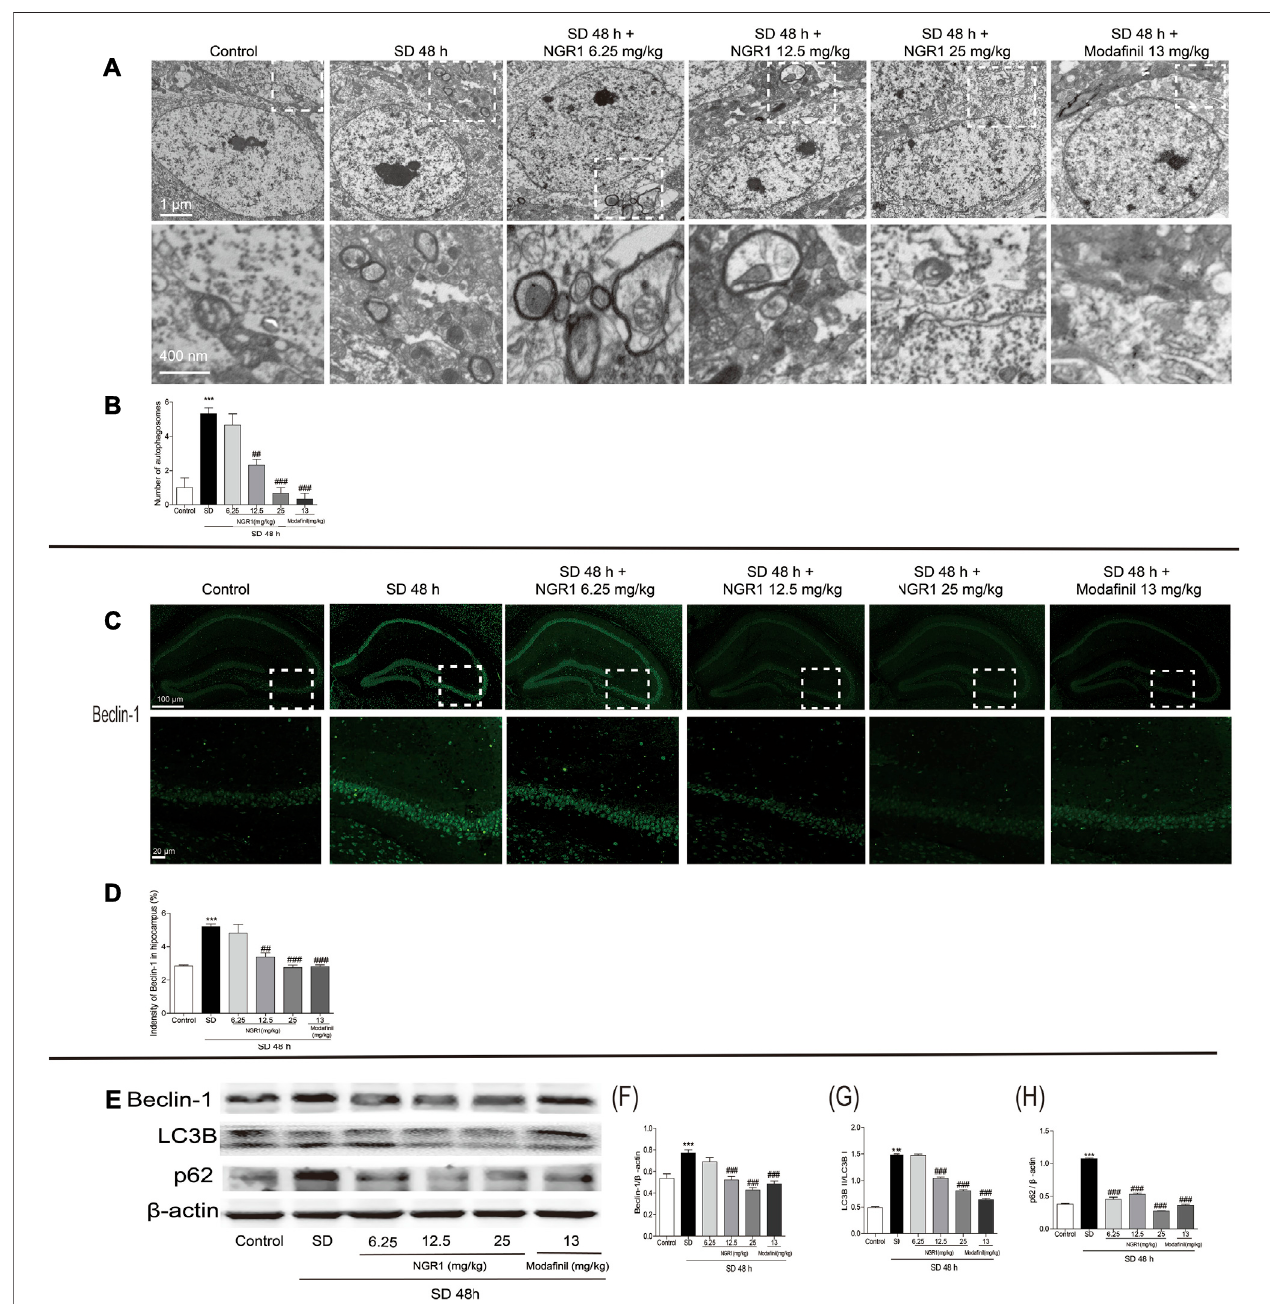
FIGURE 2| NGR1 suppressed the excessive autophagy in the hippocampus ofSD mice. (A) Autophagosomes in hippocampi examined bytransmission electron microscopy. The autophagosomes were denoted by arrows. Scale bar: 1 µm and 400 nm. (B) Comparison of the number of autophagosomes. n (cid:1) 3/group. (C) Immunostaining of beclin-1 in the hippocampus. Scale bar: 100 and 20 µm. (D) Comparison of beclin-1 immuno fl uorescence intensity. n (cid:1) 3/group. (E) Hippocampal expressionsofproteinsinvolvedinautophagy. (F – H) Grayintensitycomparisonofbeclin-1,LC3BII/I,andp62.n (cid:1) 5/group.(NGR1:notoginsenosideR1;SD:sleep deprivation; p62, and ubiquitin-binding protein p62 or sequestosome-1).